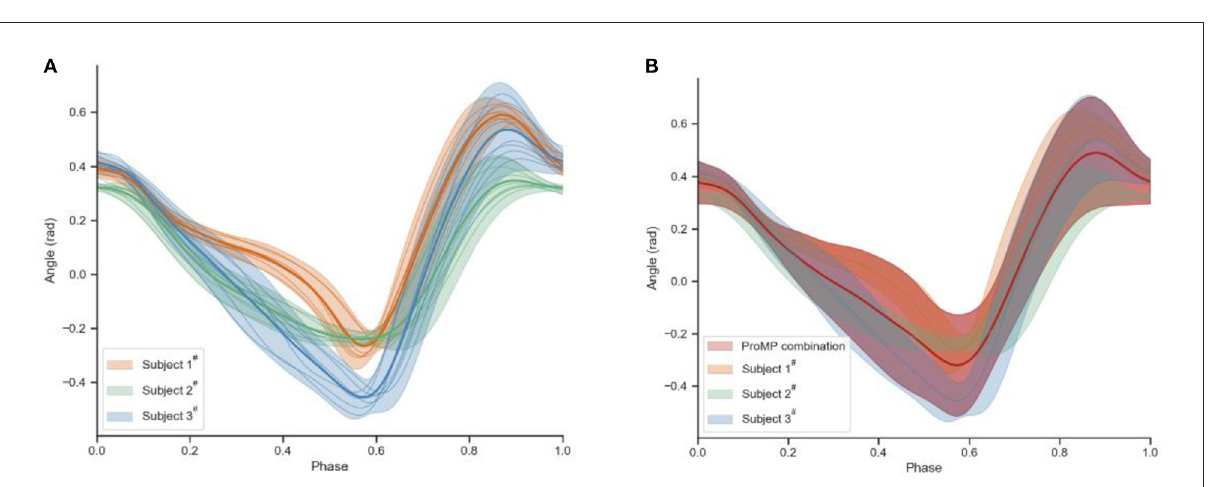
FIGURE6 (A) The cut and normalized walking data of subjects 1#, 2#, 3#. (B) ProMPs learning result.